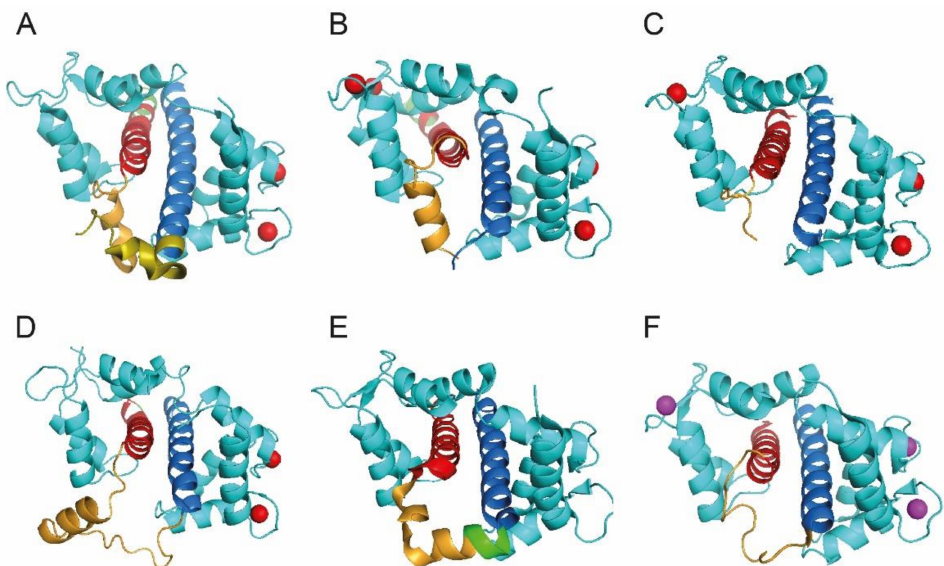
Figure 2. CaM/Kv7 complexes. Ribbon representation of CaM in complex with AB helices of Kv7 channels. CaM is colored turquoise, the helices A are red, the helices B are blue, the “TW domains” are in dark orange and, finally, Ca 2+ and Mg 2+ ions are red and magenta, respectively. Structural data were obtained from the Protein Data Bank (PDB), accession codes: ( A ) CaM/Kv 7.1hAB (4V0C, [66]); ( B ) CaM/Kv7.3hA-Kv7.2hB (5J03, [69]); ( C ) CaM/Kv7.1hAB (5VMS, [28]); ( D ) CaM/Kv7.2hAB (6FEG, [67]); ( E ) CaM/Kv7.4hAB (6B8L, [59]); ( F ) CaM/Kv7.5hAB (6B8Q, [59]). Panels A and C were simplified to show only the CaM/hAB complexes. Figures were produced with PyMOL (The PyMOL Molecular Graphics System, Version 1.5.0.4 Schrödinger,